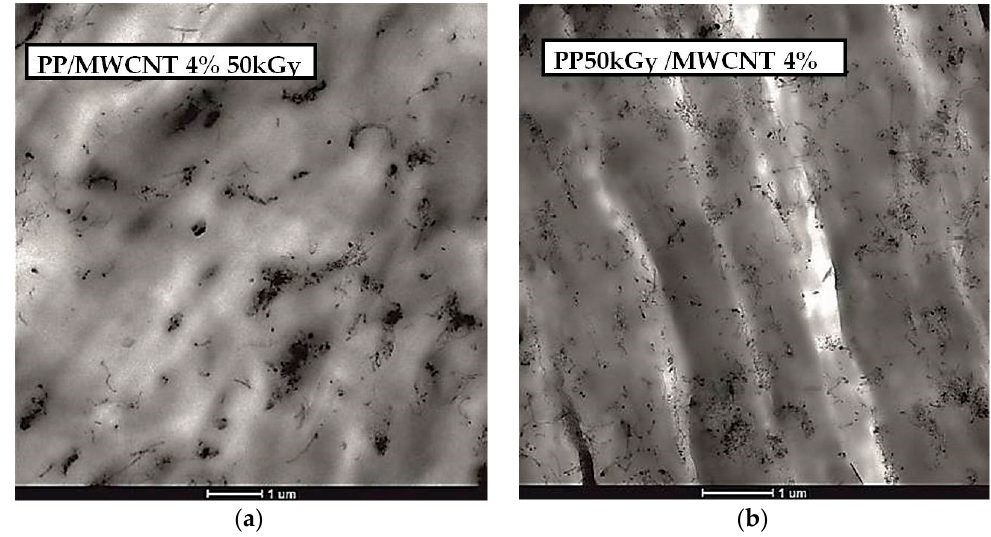
Figure 3. TEM microphotographs of 4% MWCNT nanocomposites. ( a ) Protocol A nanocomposite; ( b ) Protocol B nanocomposite. Better dispersion is observed for the nanocomposite obtained using Protocol B.